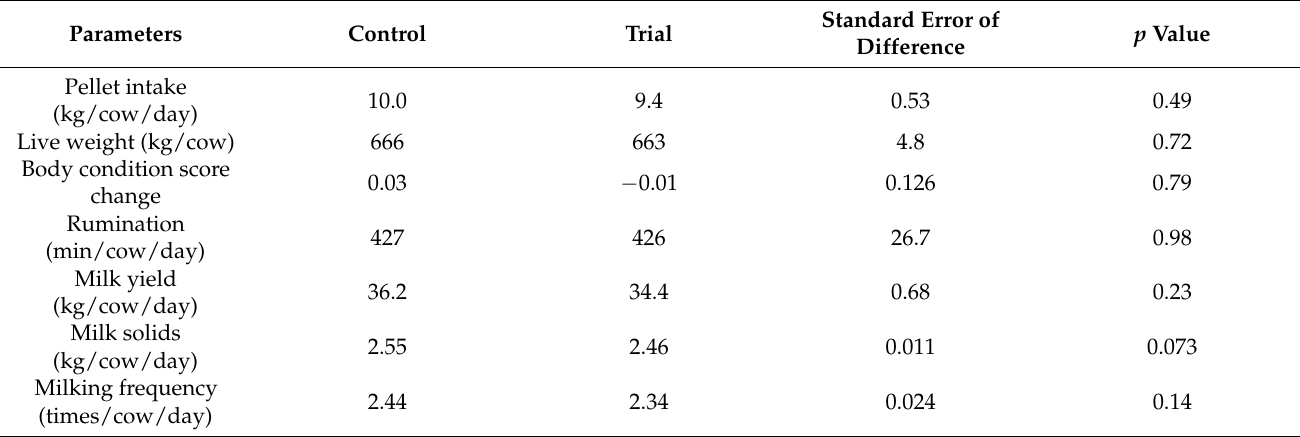
Table 3. The effect of amino acid supplementation on pellet intake, live weight, rumination time and milk production